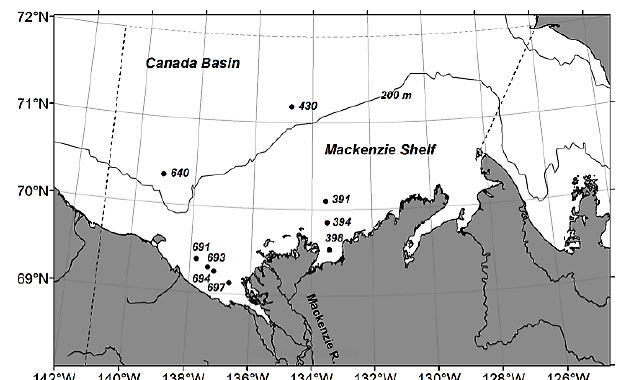
Fig. 1. Map of sampling stations. Solid line denotes the 200-m iso- bath and dashed line delimits the area for which NH + tion was